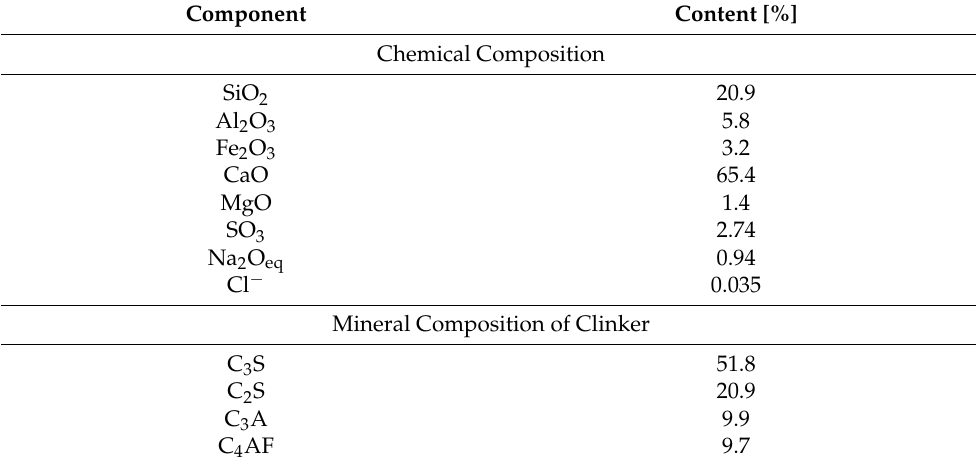
Table 2. Chemical and mineral composition of the cement used.